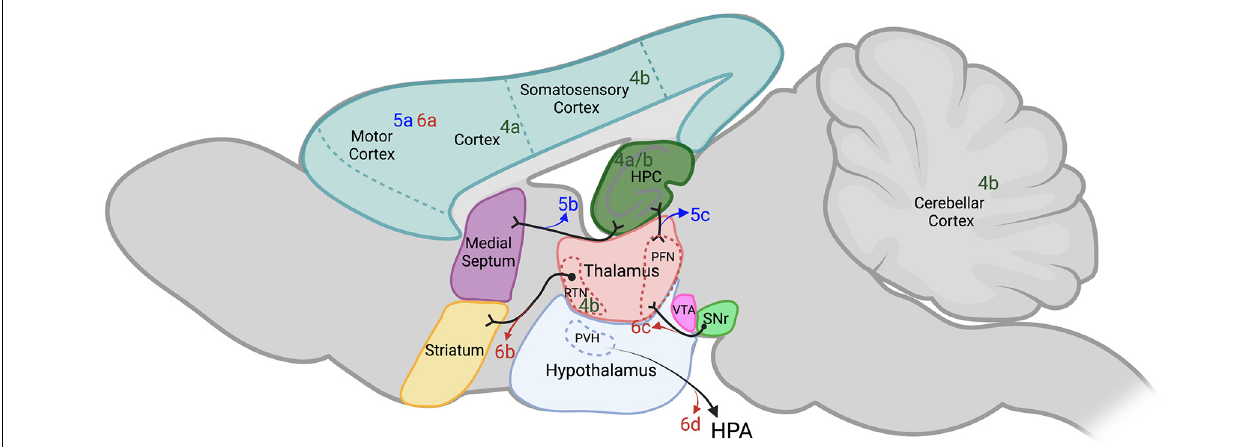
FIGURE 4 | Extrahippocampal targets of chemogenetics interrogated by each of the authors cited. Sagittal section of adult rodent brain. Table 1 provides a key to the denoted publications and is organized by where each of the authors are cited in this review. Publications denoted in green were used by the authors cited to either potentiate or induce seizures with DREADDs (figure reference designation of 4). Blue labels indicate where hM3Dq was used to decrease seizures (figure reference designation of 5). Red labels indicate where hM4Di was used to decrease seizures (figure reference designation of 6). Projections labeled in black indicate connectivity that may contribute to the circuits evaluated. Dotted lines indicate structures outside of the plane depicted. Created in BioRender.com. DREADDs, designer receptors exclusively activated by designer drugs; hM3Dq, G q -coupled human M3 muscarinic DREADD; hM4Di, G i -coupled human M4 muscarinic DREADD; HPA, hypothalamic-pituitary-adrenal axis; HPC, hippocampus; PFN, parafascicular nucleus; PVH, paraventricular hypothalamic nucleus; RTN, reticular thalamic nucleus; SNr, substantia nigra pars reticulata; VTA, ventral tegmental